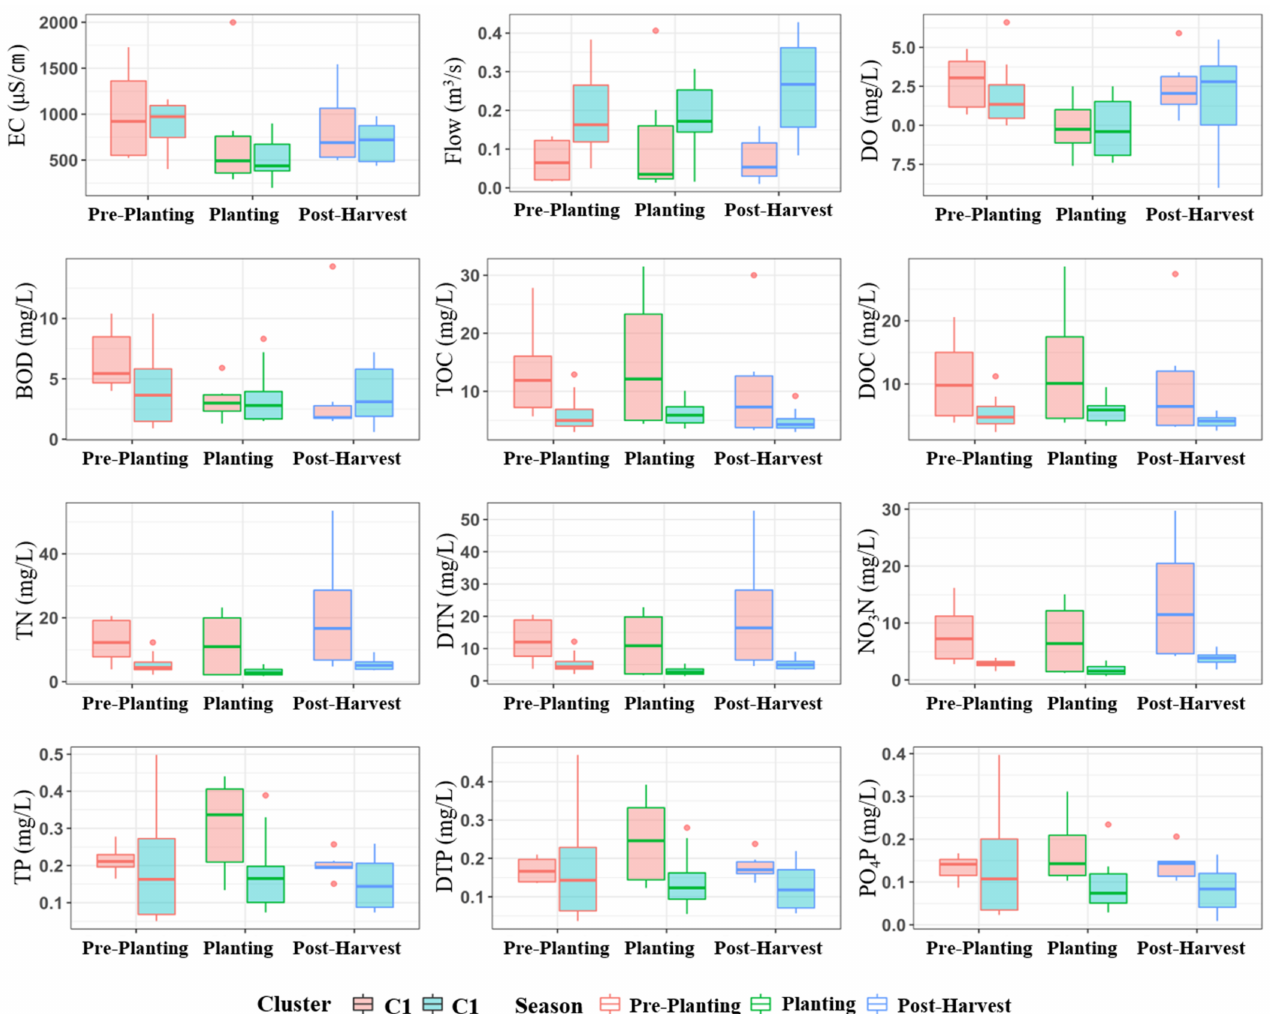
Figure 4. Analysis results for field data, organic matter parameters, and nutrient data according to the two clusters and farming